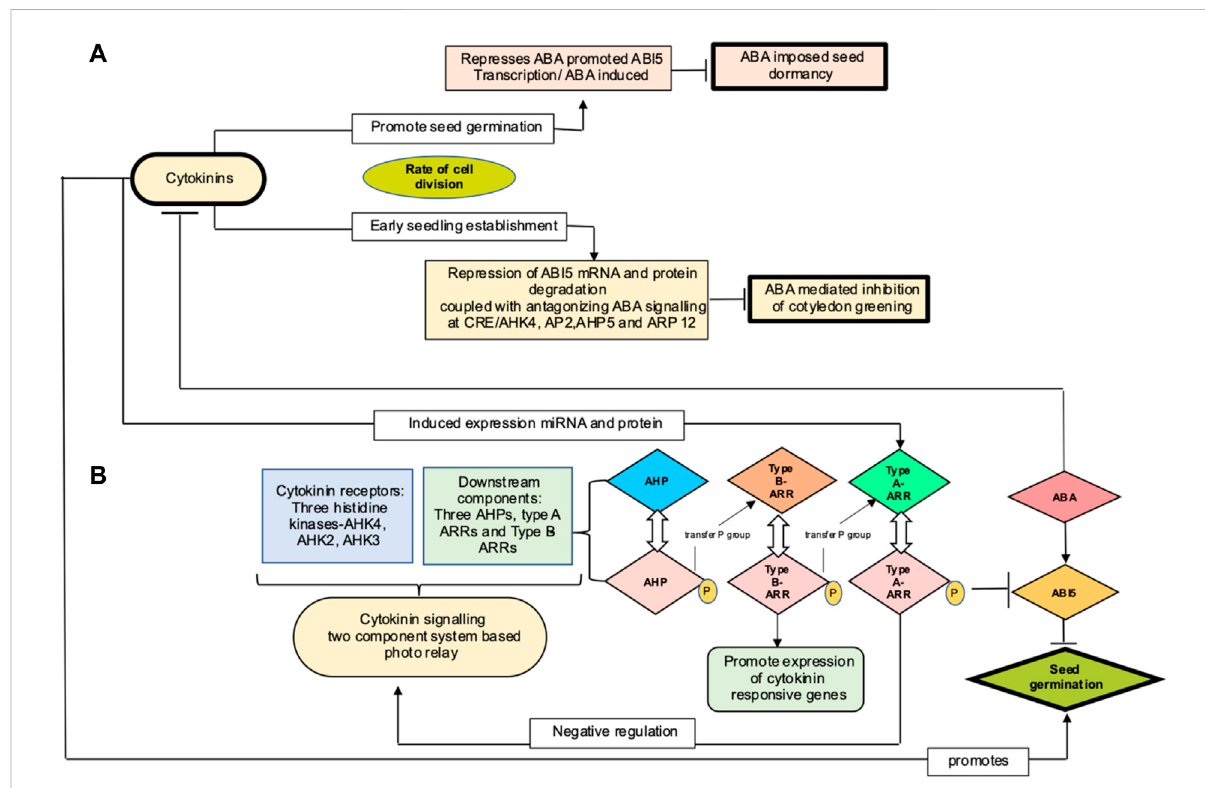
FIGURE 4 (A) Proposed mechanism for cytokinin action in regulating seed germination in Arabidopsis by Wang et al. (2011) and Guan et al. (2014), represented at top (light pink (marginal mechanism) and yellow (major mechanism) color boxes, respectively). Cytokinin in fl uences cell division to promoteseedgerminationandseedlingestablishmentandtherebyactivatesABA-imposedseeddormancyandinhibitionofcotyledongreening. (B) represents cytokinin signaling components and their interaction with ABI5 to mediate seed germination (AHK, Arabidopsis histidine kinases, ARRs, Arabidopsis response regulators; ABA, abscisic acid; ABI5 , abscisic acid insensitive protein